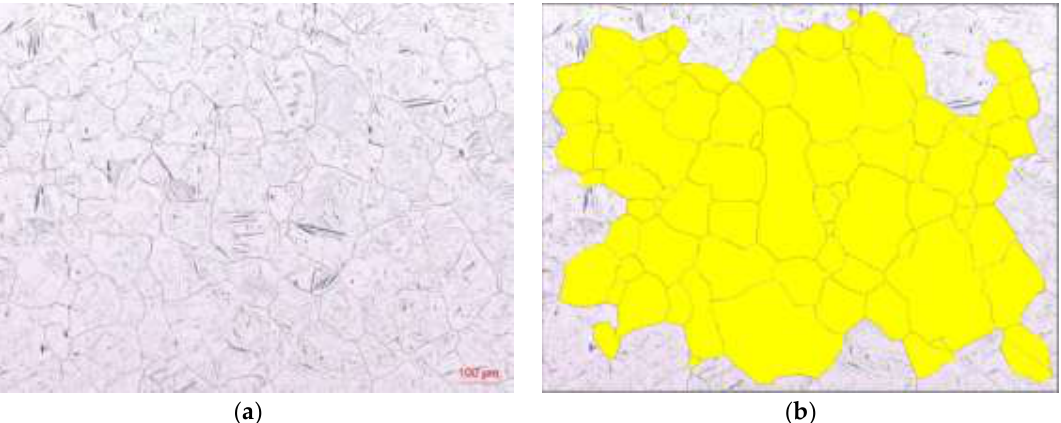
Figure 1. ( a ) Initial image of austenite obtained using optical microscopy and ( b ) after the detection process using analysis software after quenching.